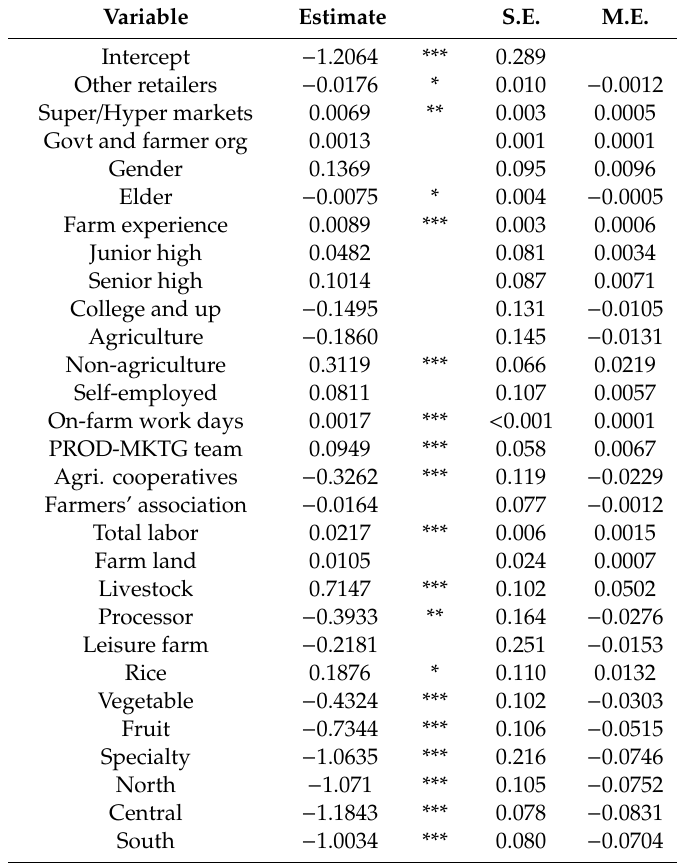
Table 3. Probit estimates and marginal e ff ects on contract farming